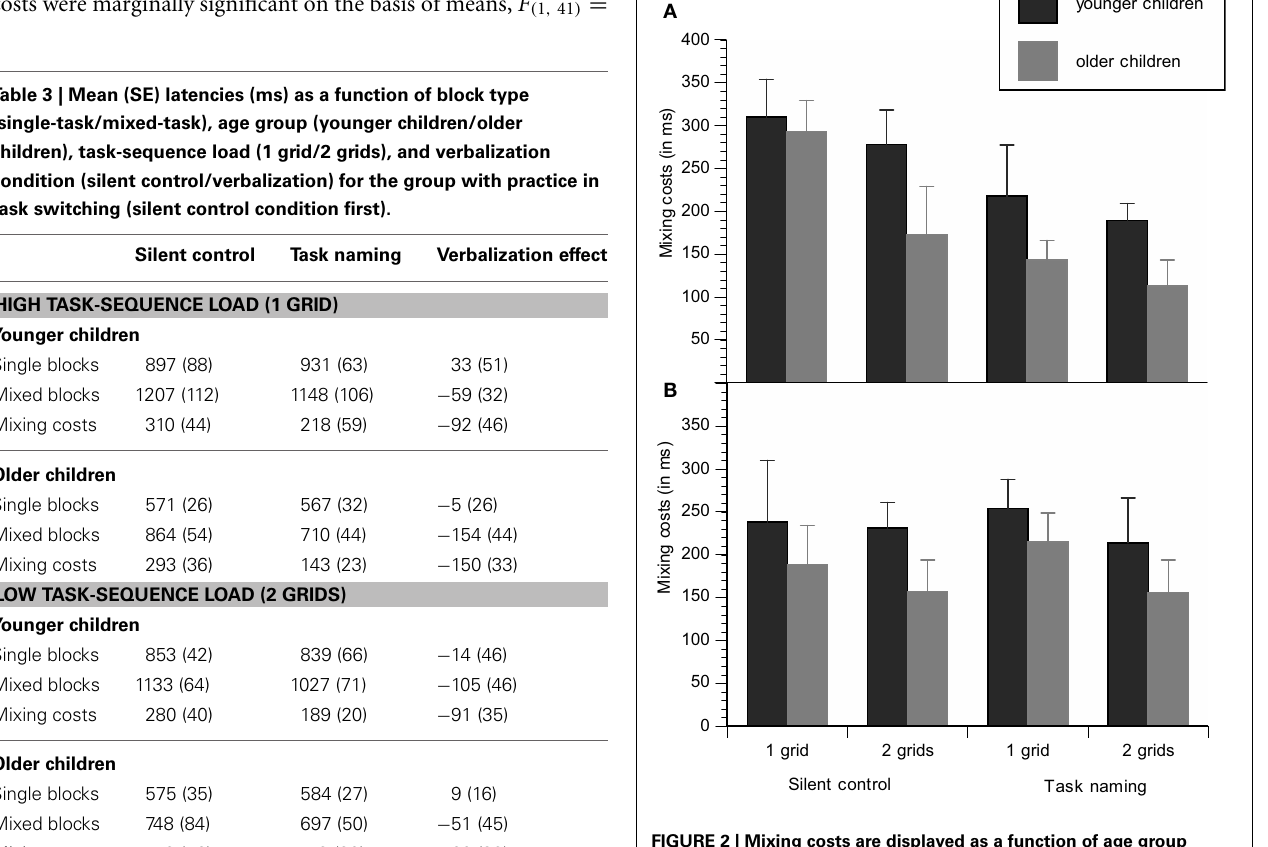
FIGURE 2 | Mixing costs are displayed as a function of age group (younger children/older children), task-sequence load (1 grid/2 grids), and verbalization condition (silent control/task naming) for the group with practice in task switching (silent condition first) (A) and the group without practice in task switching (verbalization condition first) (B)